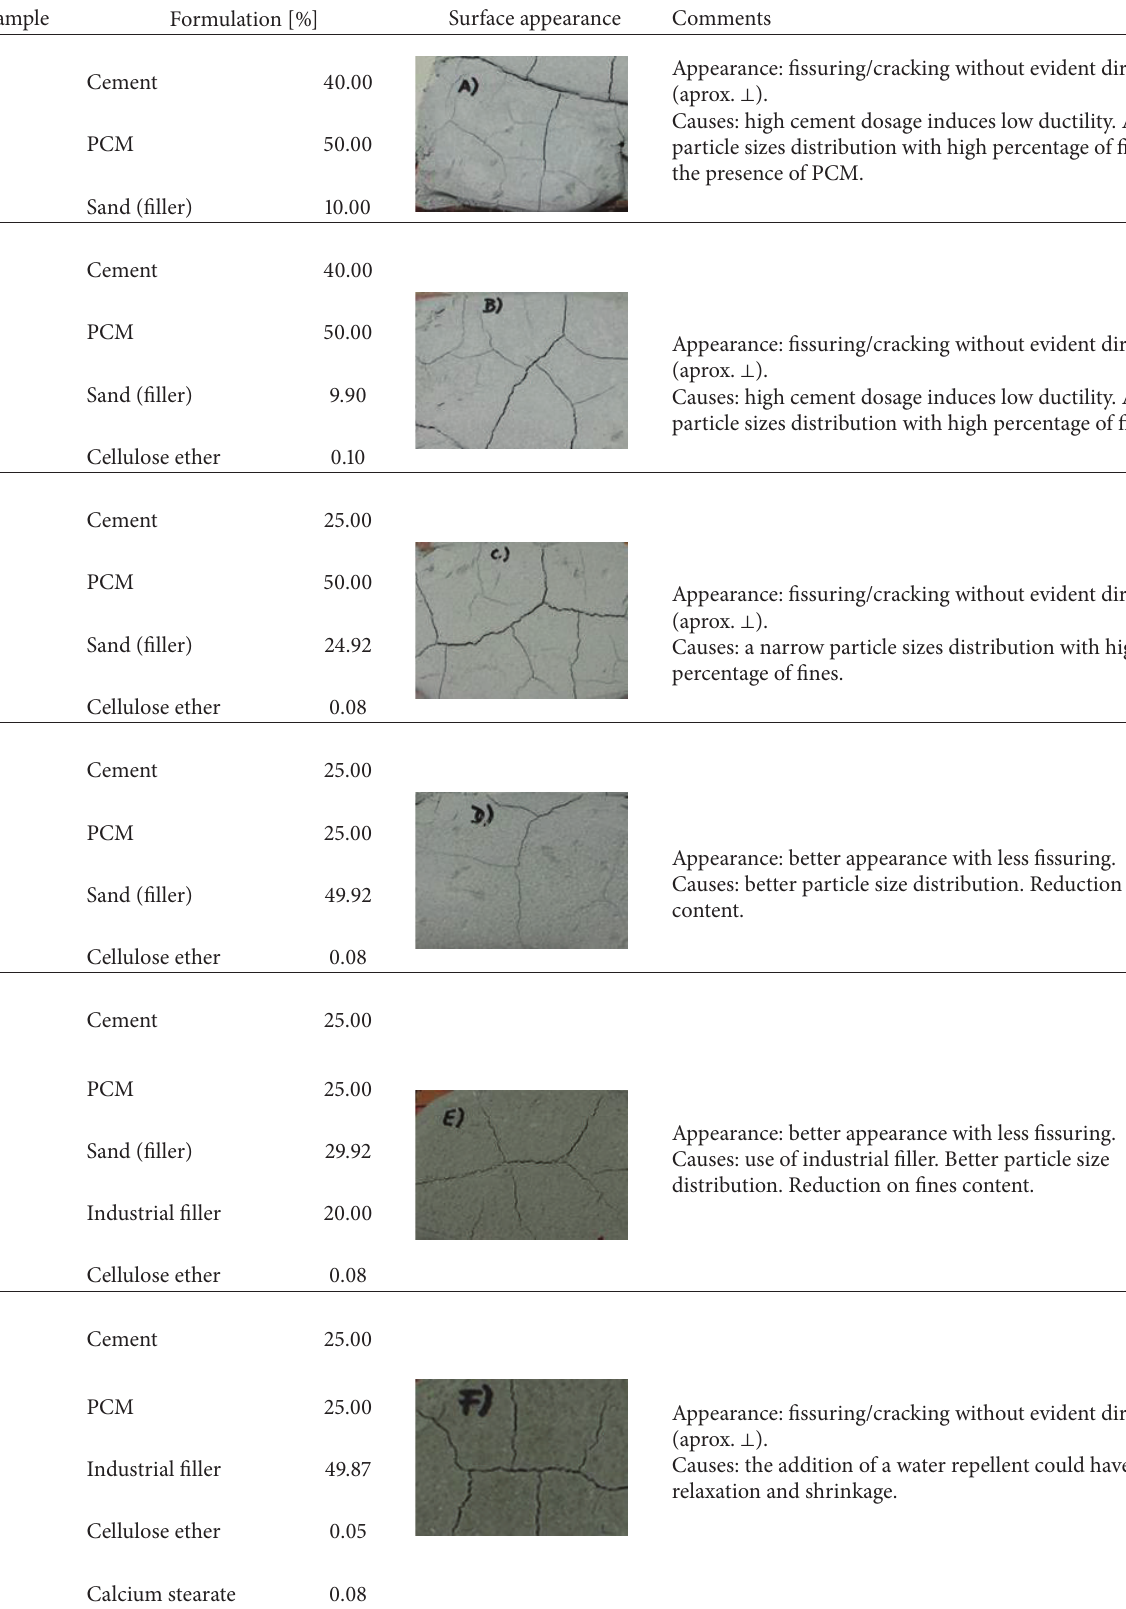
Table 2: Mix proportions of formulations A to L and REFM and surface appearance of samples A to L.